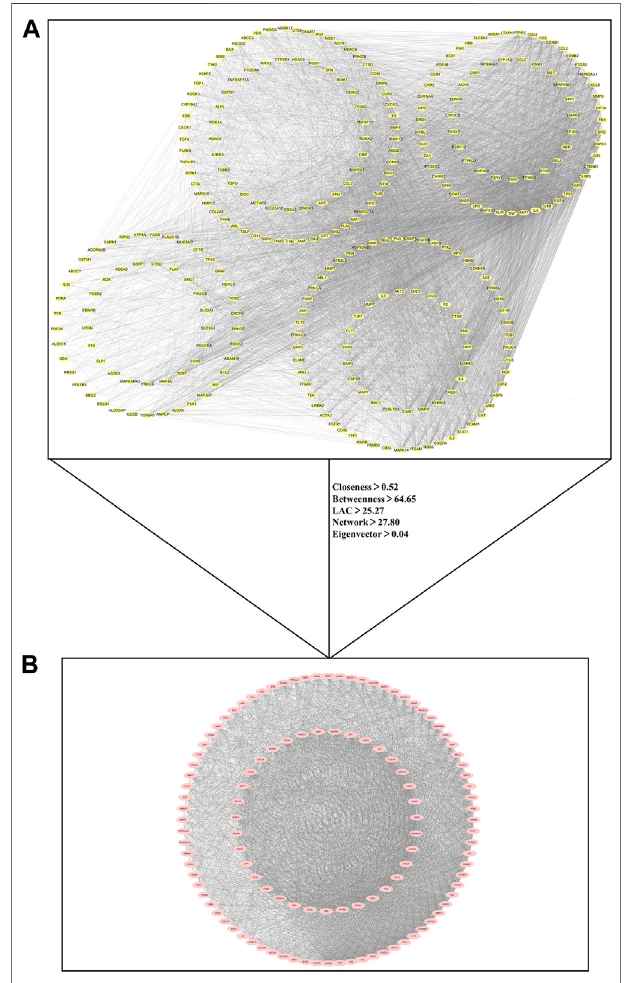
FIGURE3| Protein-proteininteraction(PPI)networkforcriticaltargetsof kaempferol against COVID-19/pulmonary fi brosis co-occurrence. Nodes represent targets and edges represent protein-protein interactions. (A) PPI networkof290commontargetsbetweenCOVID-19, pulmonary fi brosis and kaempferol. (B) PPI network of 115 critical targets for kaempferol against COVID-19/pulmonary fi brosis co-occurrence.